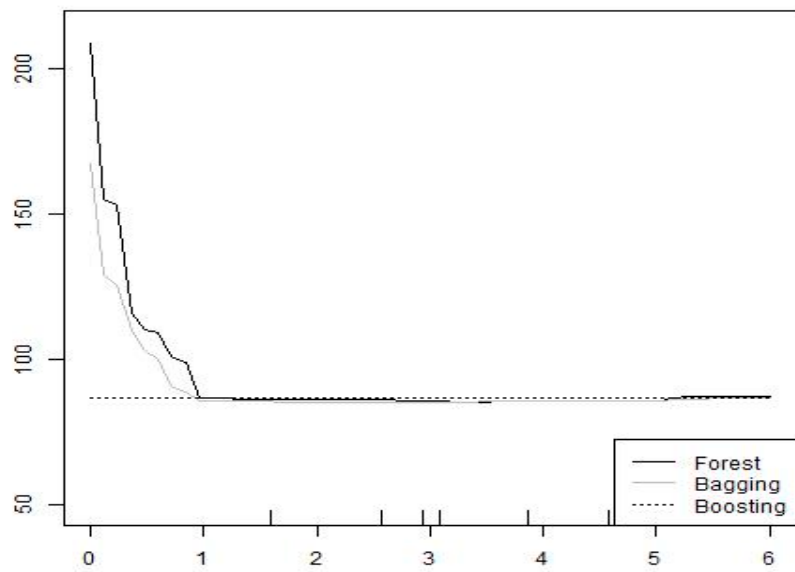
Figure 4. Partial dependence plot: military in politics.